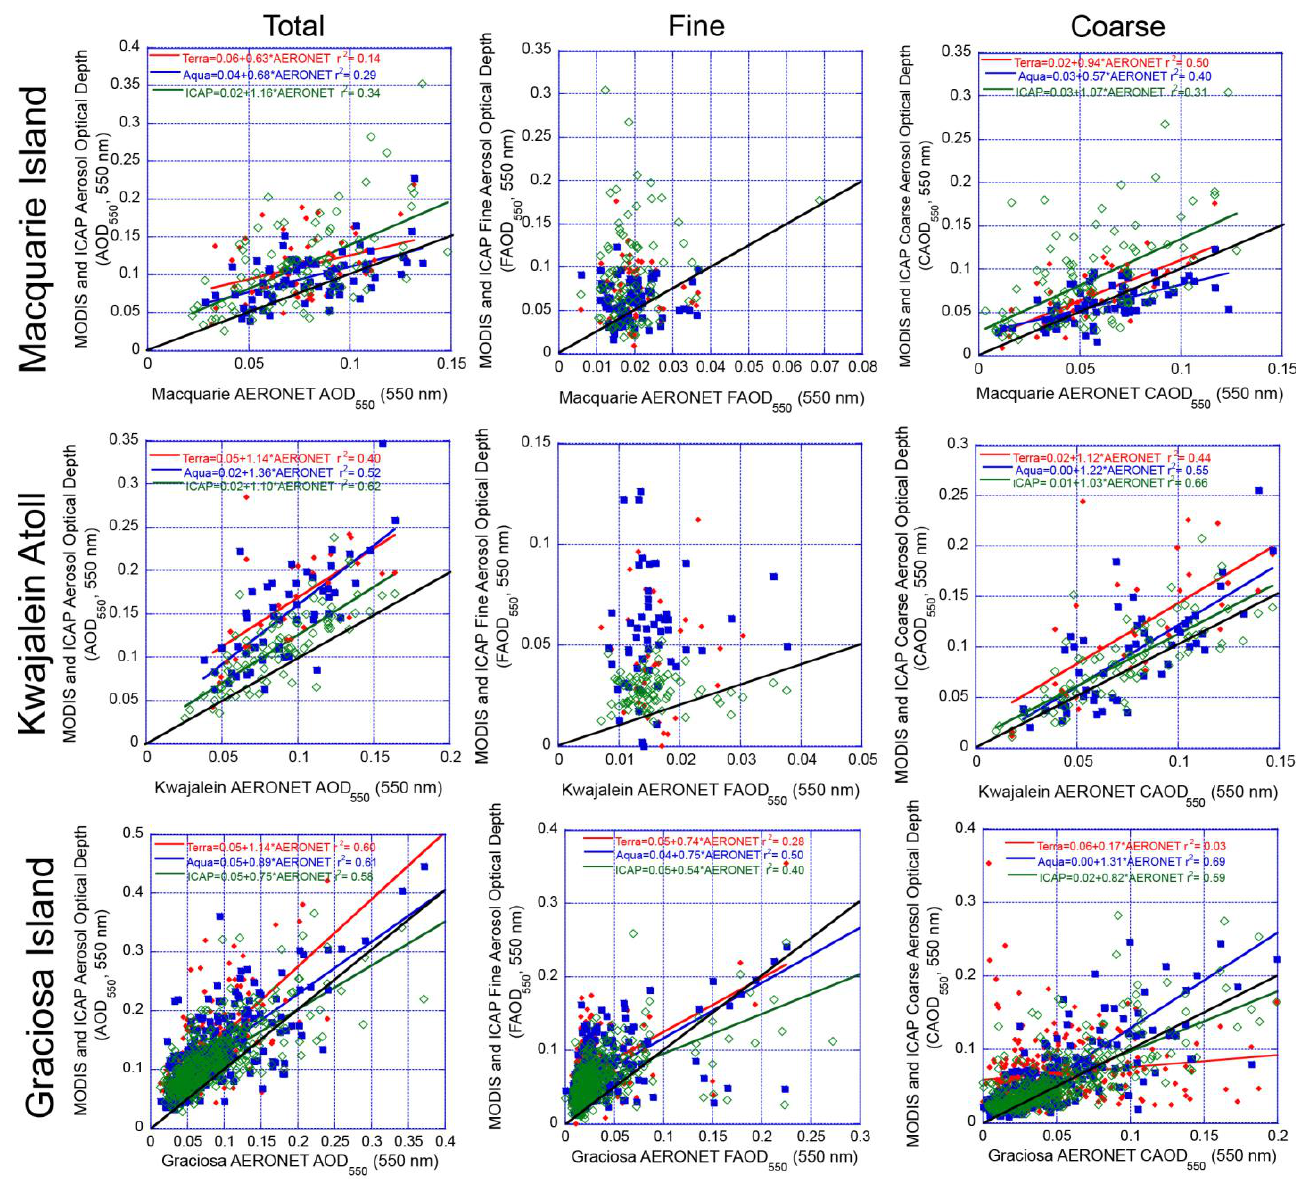
Figure 16. Scatter plots of total AOD (AOD 550 ), fine mode AOD (FAOD 550 ), and coarse mode AOD (CAOD 550 ) for daily averages from three AERONET sites located in remote marine environments. These nominally correspond to the MAN domains of <30°S (Macquarie Island; 54.5°S,158.9°E), central subtropical-tropical Pacific (Kwajalein Atoll; 8.8°N,167.7°E), and Northern mid-latitudes (Graciosa Island; 39.1°N, 28.0°W).